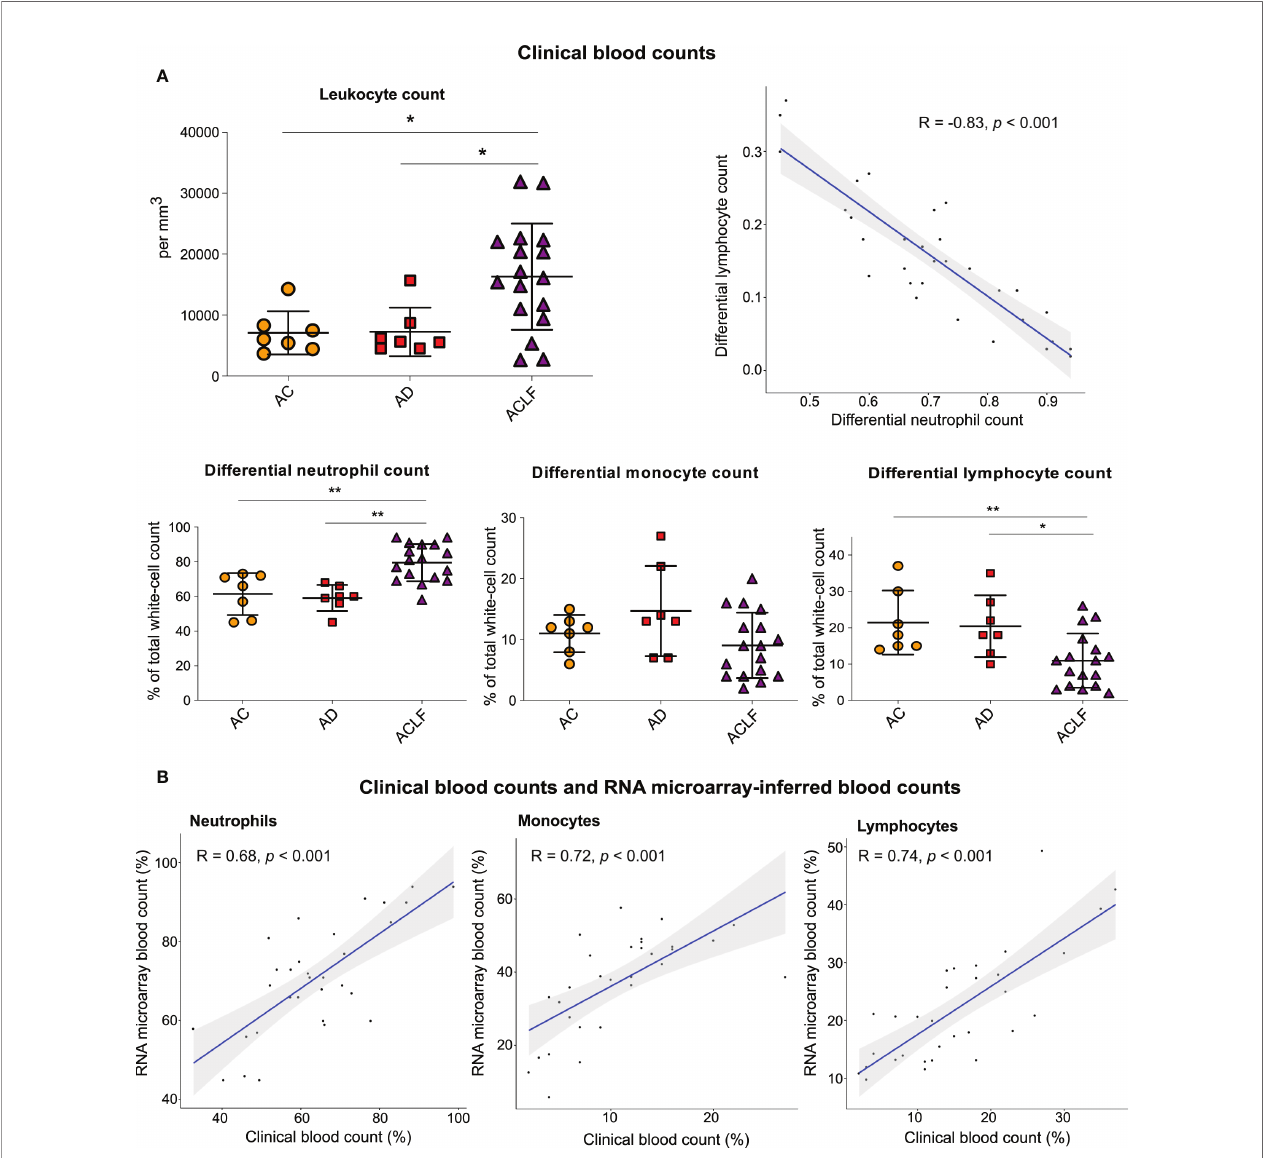
FIGURE 1 | Results of clinical blood counts and RNA microarray-inferred blood counts. (A) Clinical complete blood counts in three groups of patients with cirrhosis: AC (orange circles, n=7), AD (red square, n=7) and ACLF (purple triangle, n=17). P values were obtained using Kruskal – Wallis test and Mann – Whitney test. **P <0.01; *P <0.05. (B) Neutrophil, lymphocyte, and monocyte counts in paired clinical complete blood counts as compared with the CIBERSORT-inferred blood counts from RNA microarray data obtained with the use of peripheral blood (31 paired specimens). The shaded areas represent the 95% con fi dence intervals. AC denotes advanced cirrhosis, AD acute decompensation, and ACLF acute on chronic liver